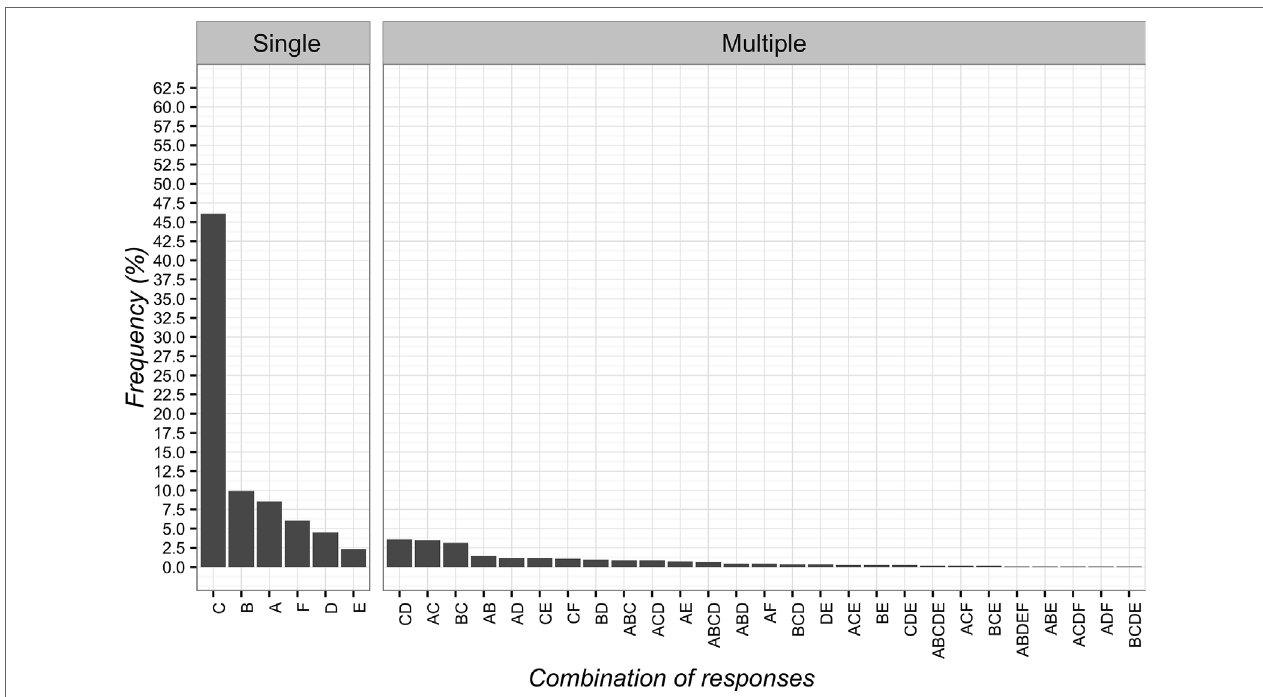
FIGURE 5 | Percentages of responses for communicating to patients the implications of Contextual Factors. (A) it is a treatment that can help and will not hurt; (B) it is an effective treatment; (C) it is a treatment without a specific effect for your problem, but capable of improving your condition; (D) it is a treatment that induces a psychological change; (E) it can help but you are not sure about its effect; (F) you do not receive any